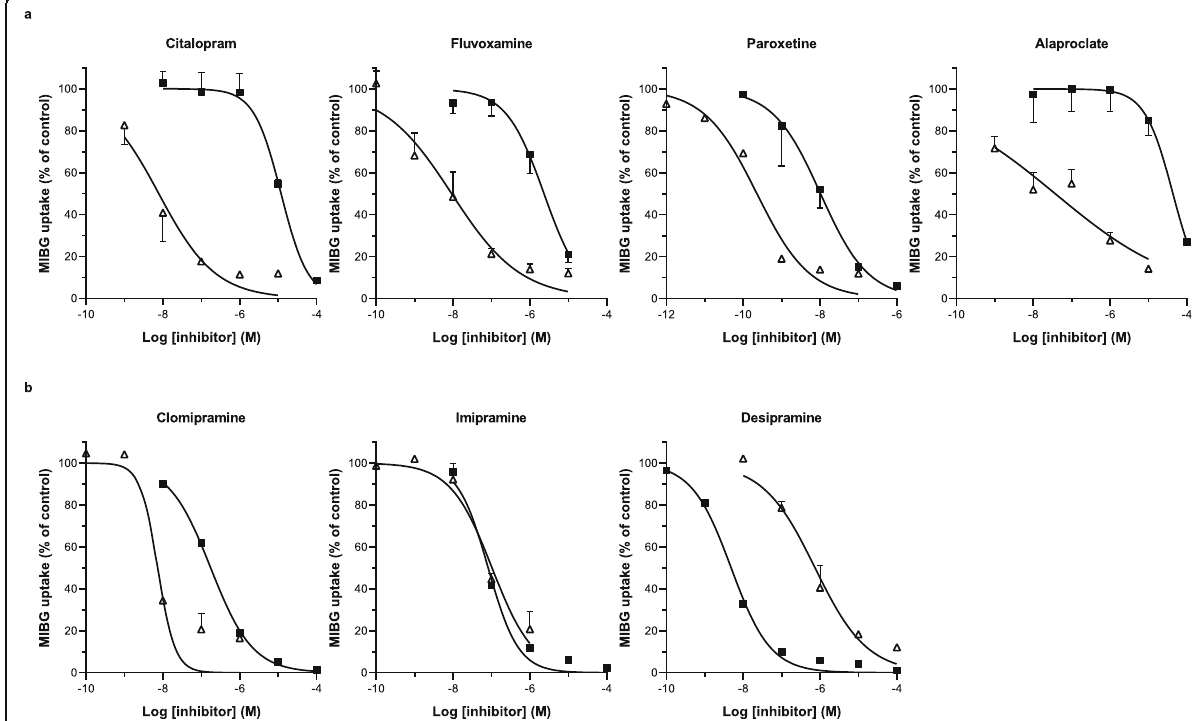
Fig. 5 Inhibition of [ 125 I]MIBG uptake by SSRIs and tricyclic antidepressants in human platelets and cultured SK-N-SH neuroblastoma cells. [ 125 I]MIBG uptake in isolated human platelets is depicted by open symbols ( Δ ), and [ 125 I]MIBG uptake in cultured human SK-N-SH neuroblastoma cells by closed symbols ( ■ ). Samples were incubated at 37 °C for 4 h with a substrate concentration of 10 − 8 M. MIBG uptake is expressed as the percentage of control without inhibitor. Data represent mean ± SD ( n ≥ 3)